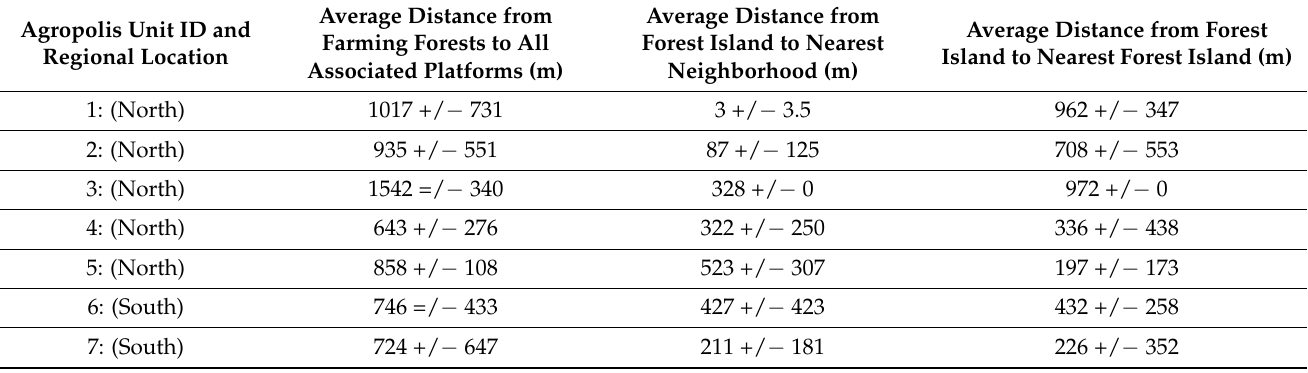
Table 7. Descriptive statistics for the seven agropolises identified, five in the north, and two in the south (see Figure